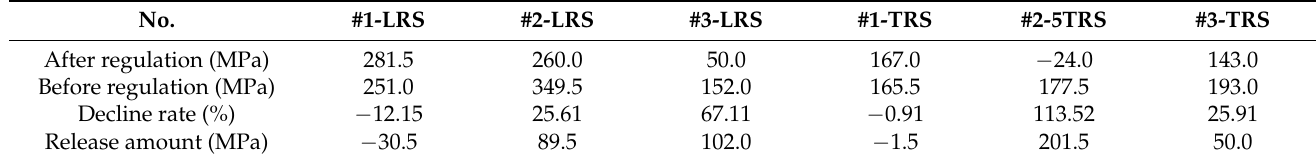
Table 6. Peak residual stress changes on the front side of samples #1, #2, and #3.